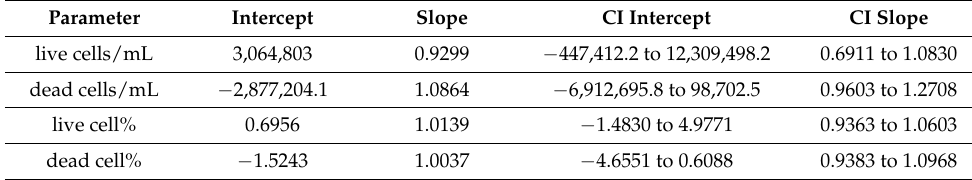
Table 1. Results from Passing Bablok